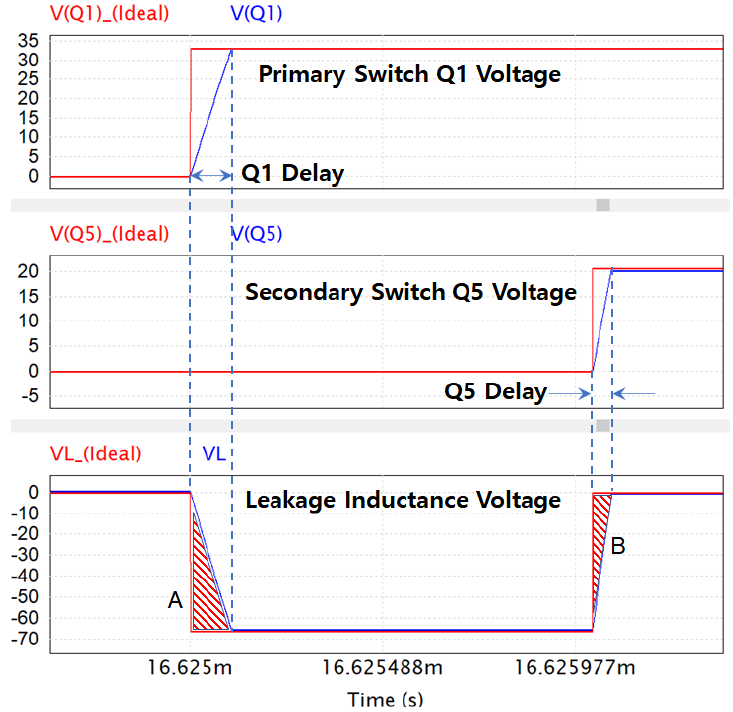
Figure 5. Voltage characteristics of the DAB converter according to the delay time.